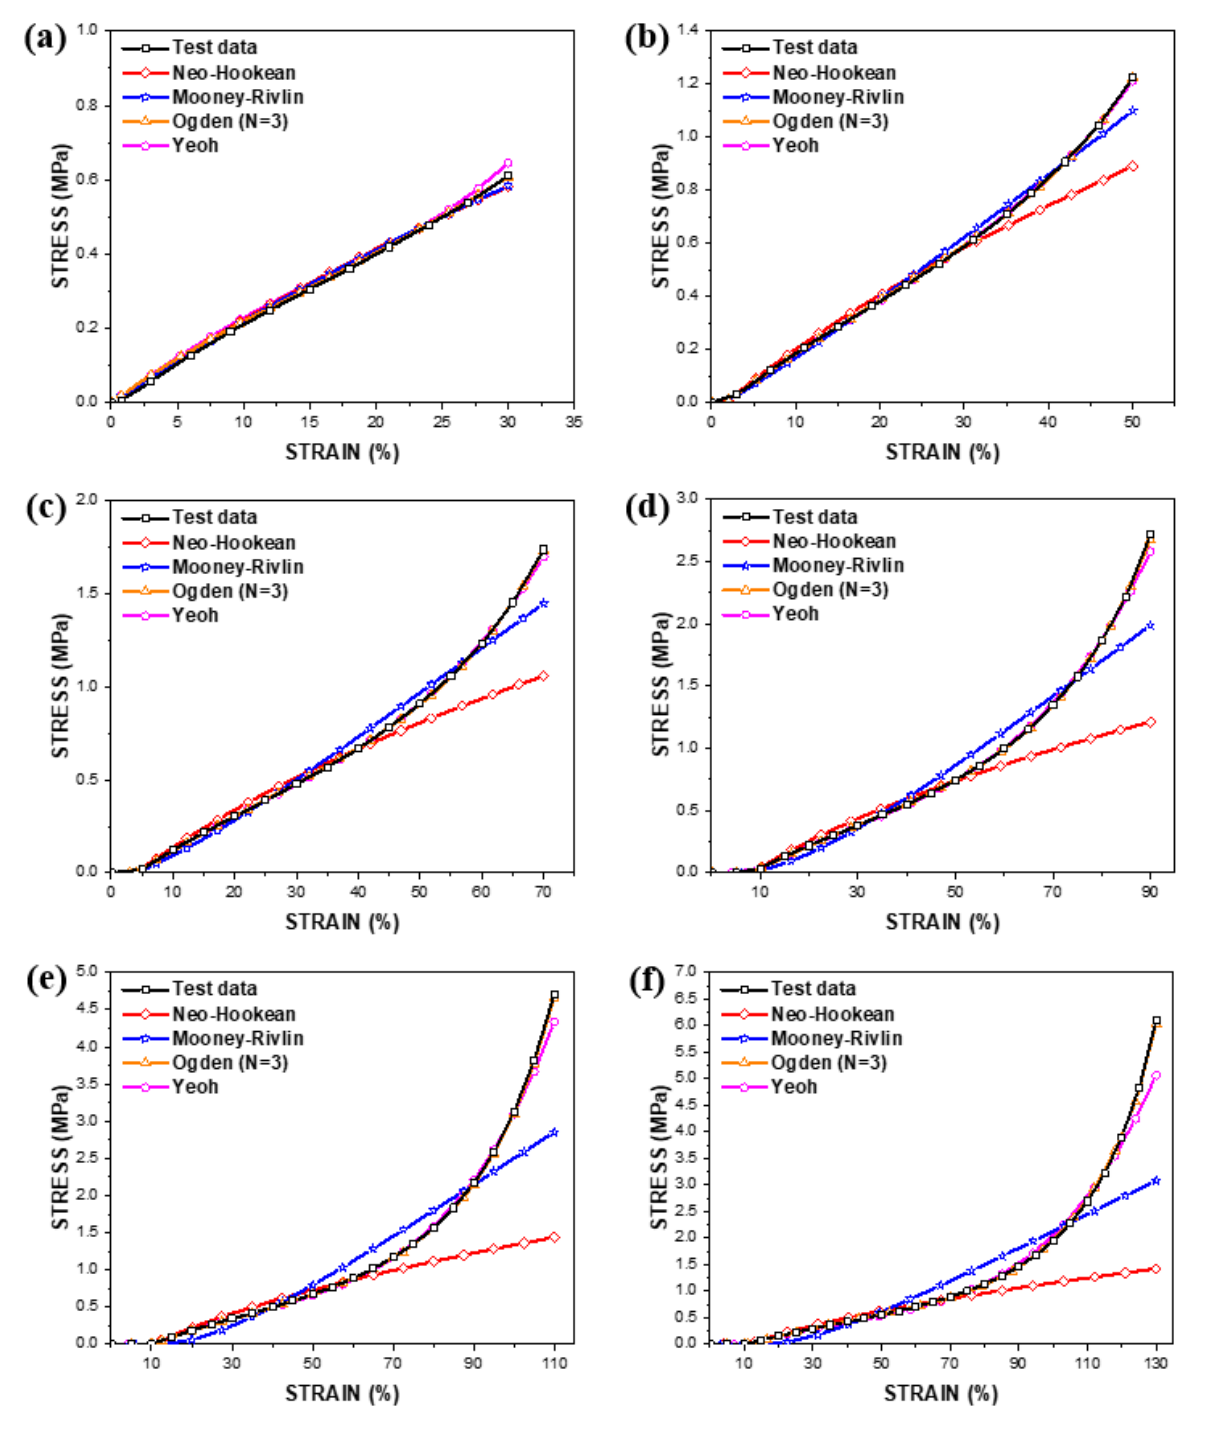
Figure 9. Hyperelastic curve fittings for the PDMS film with a thickness of 150 µ m: ( a ) 30%, ( b )